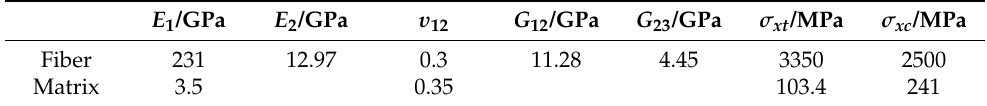
Table 1. Mechanical properties of fiber and matrix.